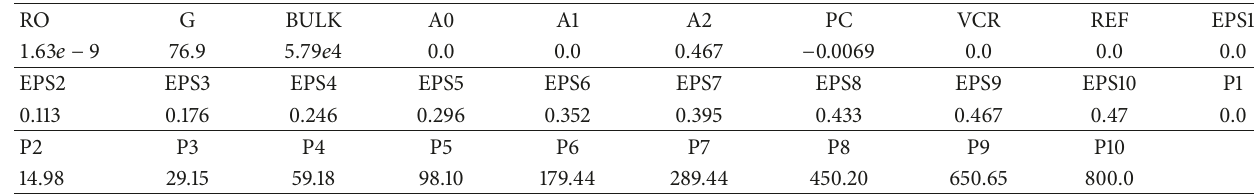
Table 4: Corresponding parameters of MAT_SOIL_AND_FOAM